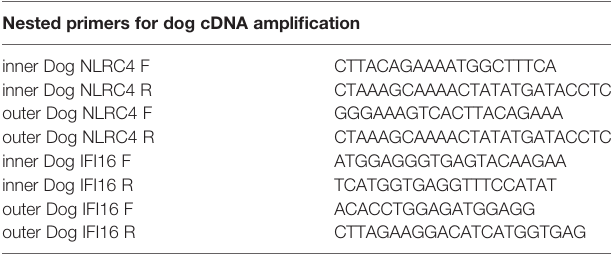
TABLE 1 | The nested primers used in dog cDNA ampli fi cation.